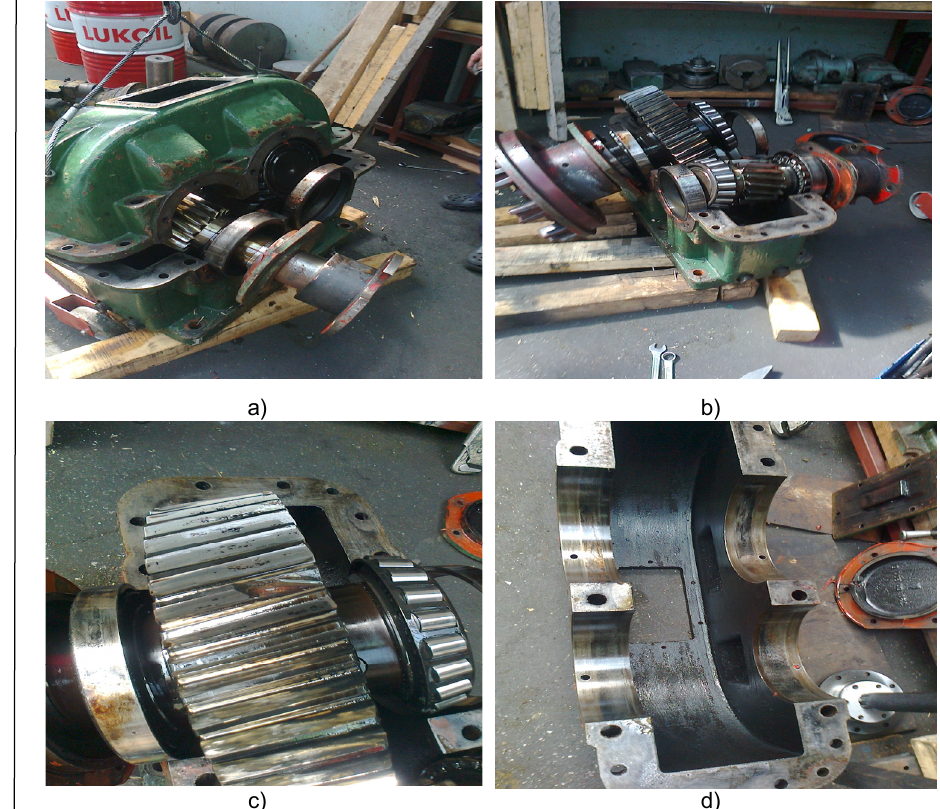
Figure 7 – Damaged parts of the multiplier of a hydropower plant Рисунок 7 – Изображение поврежденных деталей мультипликатора ГЭС Слика 7 – Приказ оштећених делова мултипликатора